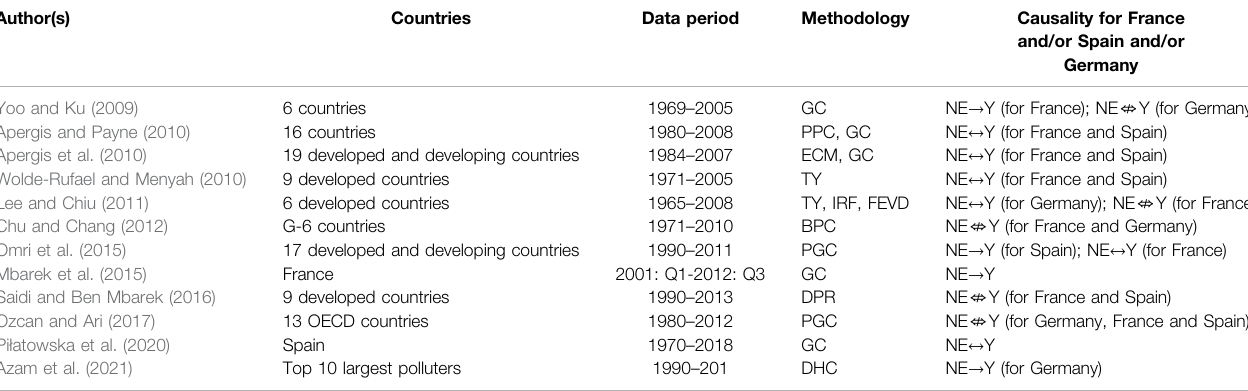
TABLE 1 | Summary of previous nuclear energy-growth nexus